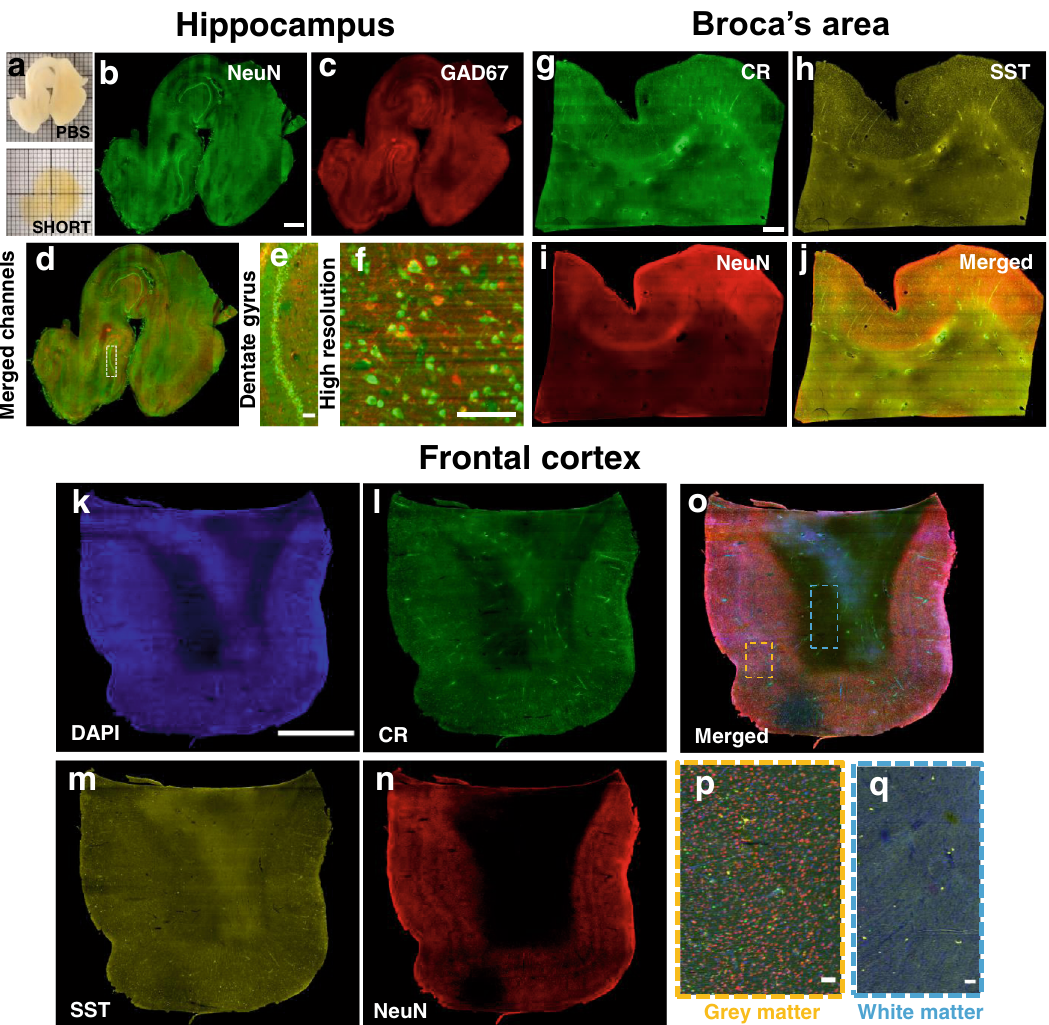
Fig. 4 SHORT combined with LSFM enables single cell-resolved imaging of large portions of adult human slices. a Image of a typical 500 μ m-thick adult hippocampus slice before and after SHORT. b Maximum intensity projection (number slices: 140) image shows a mesoscopic reconstruction of the processed hippocampus slice labeled for NeuN (excitation light 488 nm) and ( c ) GAD67 (excitation light 561 nm), and ( d ) merged channels. Scale bar = 1 mm. e Higher magni fi cation on the dentate gyrus and ( f ) example of high-resolution single cell resolved imaging with our custom-made LSFM. Scale bar = 100 μ m. ( g – i ) MIP of 20 slices of Broca ’ s area labeled for CR ( g ), SST ( h ), and NeuN ( i ). j Merged channels. Scale bar = 1 mm. k – q MIP images (slice number 20) of the frontal cortex labeled using the nuclear marker DAPI ( k ), CR ( l ), SST ( m ), and NeuN ( n ). o Merged channels. Scale bar = 4 mm. p Magni fi ed images of the white matter (blue rectangle), characterized by a high distribution of SST-immunoreactive neurons, and ( q ) grey matter (orange rectangle). Scale bar = 100 μ